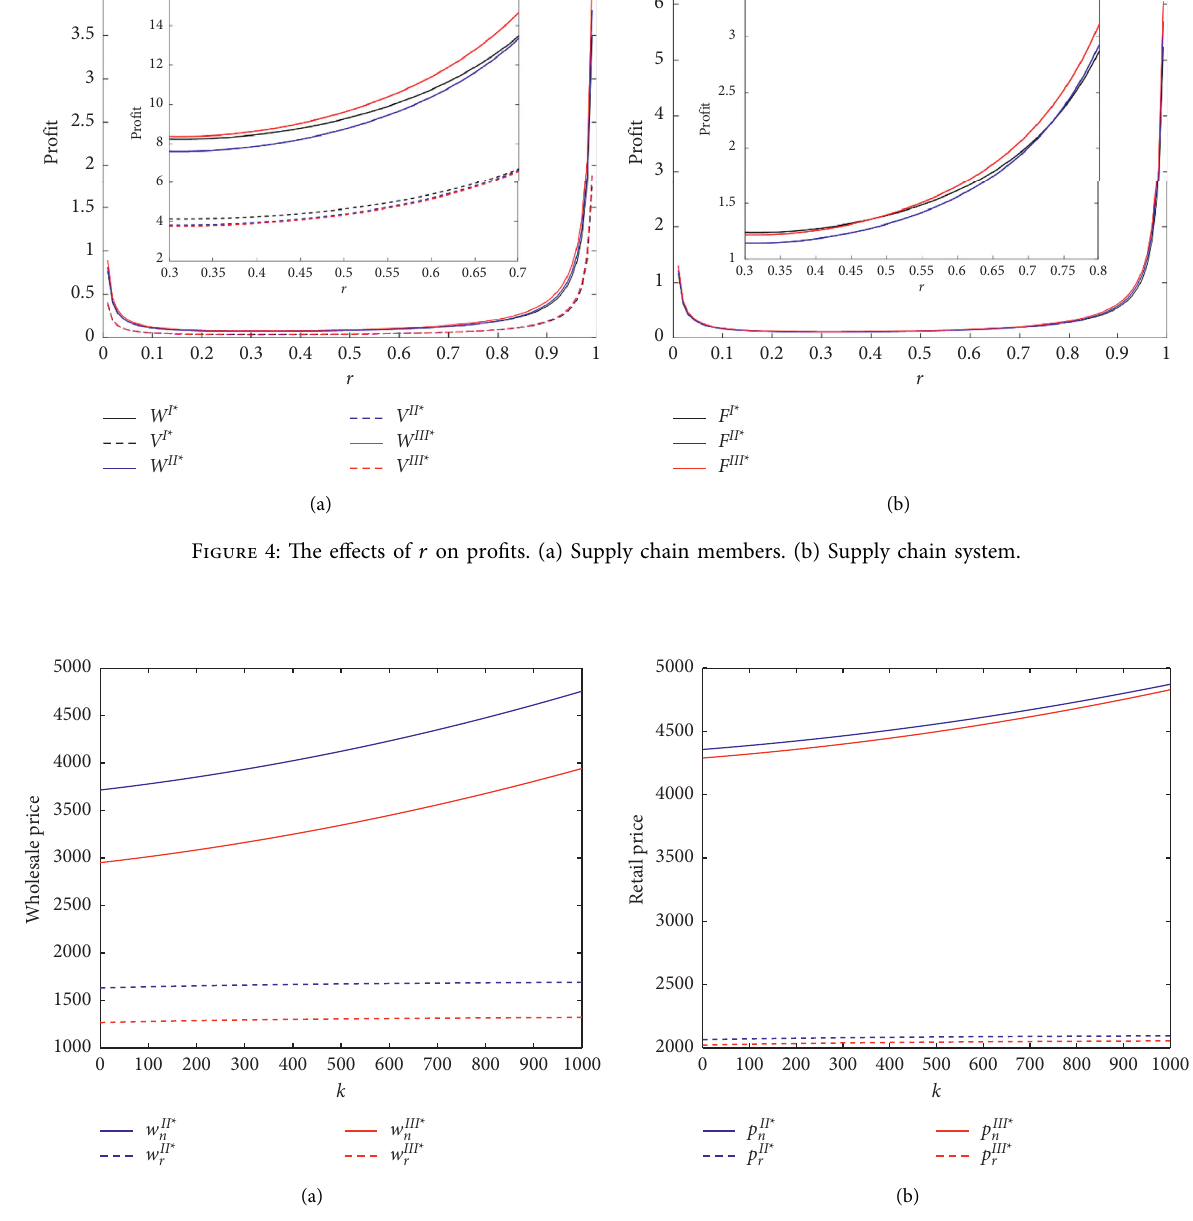
Figure 5: The effects of k on prices. (a) Wholesale prices. (b) Retail